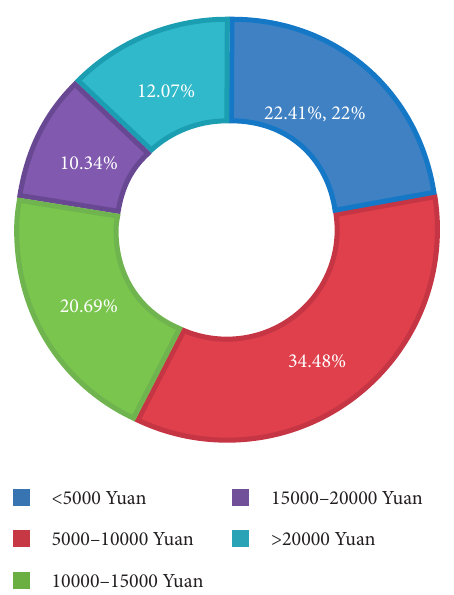
Figure 2: Distribution of monthly income of respondents’